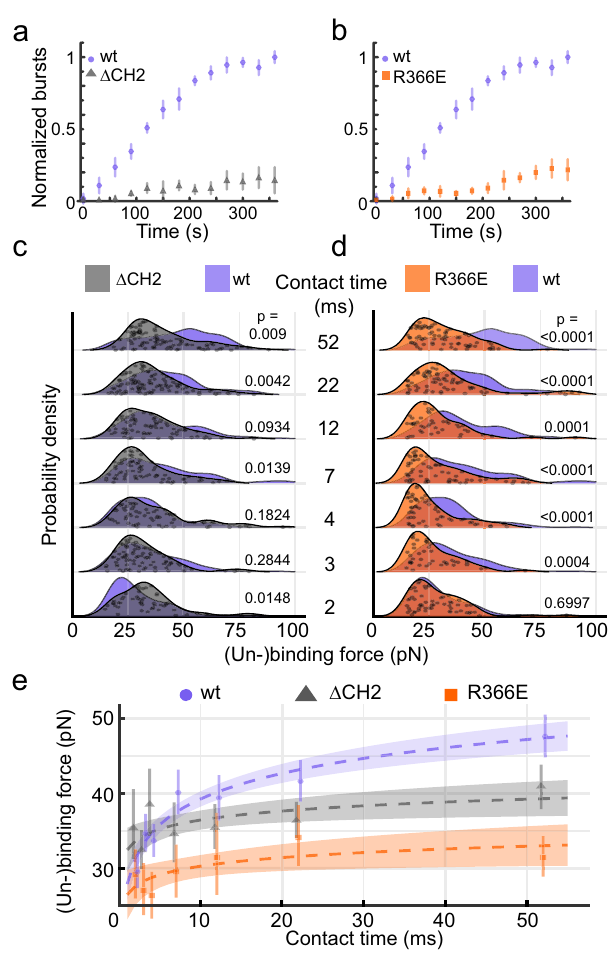
Fig. 4 YidC mutated in the cytoplasmic region or hydrophilic groove binds Pf3 with different forces. a , b Pf3 insertion into mutant Δ CH2 YidC (grey) or mutant R366E YidC (orange) and wt (purple) YidC proteoliposomes as measured by FCS. The Atto520 dye attached to the N-terminal end of Pf3 is quenched outside proteoliposomes and bursts fl uorescence upon translocation via YidC into proteoliposomes. Data points represent means from 35 measurements and error bars sd. c , d (Un-) binding forces of Δ CH2 YidC (grey) or R366E YidC (orange) and the Pf3 polypeptide as detected by FD-AFM at different contact times (grey). Overlaid are (un-)binding forces of wt YidC and Pf3 (purple). Grey dots show data points from which the probability density functions (lines and shaded areas) were constructed. For better display data points were randomly scattered along the y -axis. Probability density functions from wt YidC were taken from Fig. 2c. Force – distance curves showing single unbinding events from either wt YidC, mutant Δ CH2 YidC or mutant R366E YidC are exempli fi ed in Supplementary Fig. 16. e Multivariate linear regression (dashed lines) of wt (purple), R366E (orange) and Δ CH2 (grey) YidC built on the mean (un-)binding forces (dashed lines) of Pf3. The y - intercept equals 27.9 ± 2.2 pN (±95% CI), 32.5 ± 2.9 pN, and 26.5 ± 3.3 pN for wt, Δ CH2, and R366E YidC, respectively. Slopes of the (un-)binding forces equal 4.94 ± 0.91 pN s – 1 , 1.74 ± 1.48 pN s – 1 and 1.66 ± 1.61 pN s – 1 for wt, Δ CH2 and R366E YidC, respectively. Circular, triangle and square data points give means (wt YidC, n events = 899; mutant R366E YidC, n = 408; mutant Δ CH2 YidC, n = 556) for each contact time. events events Shaded areas indicate 95% CI and error bars represent 95% CI of the means. Force distributions were statistically compared with a two-sided Mann – Whitney U-test showing P -values for each compared